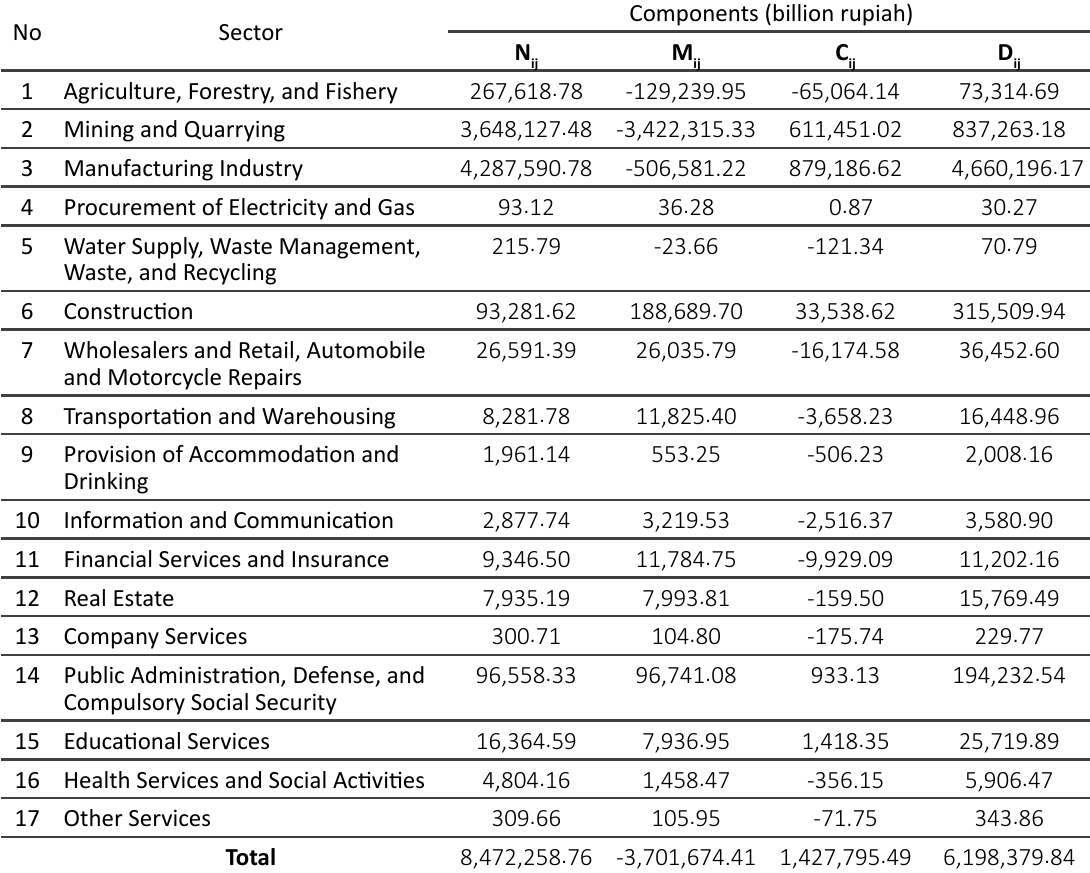
Table 3: Results of Shift-Share Analysis of GRDP (using constant price), 2010-2018